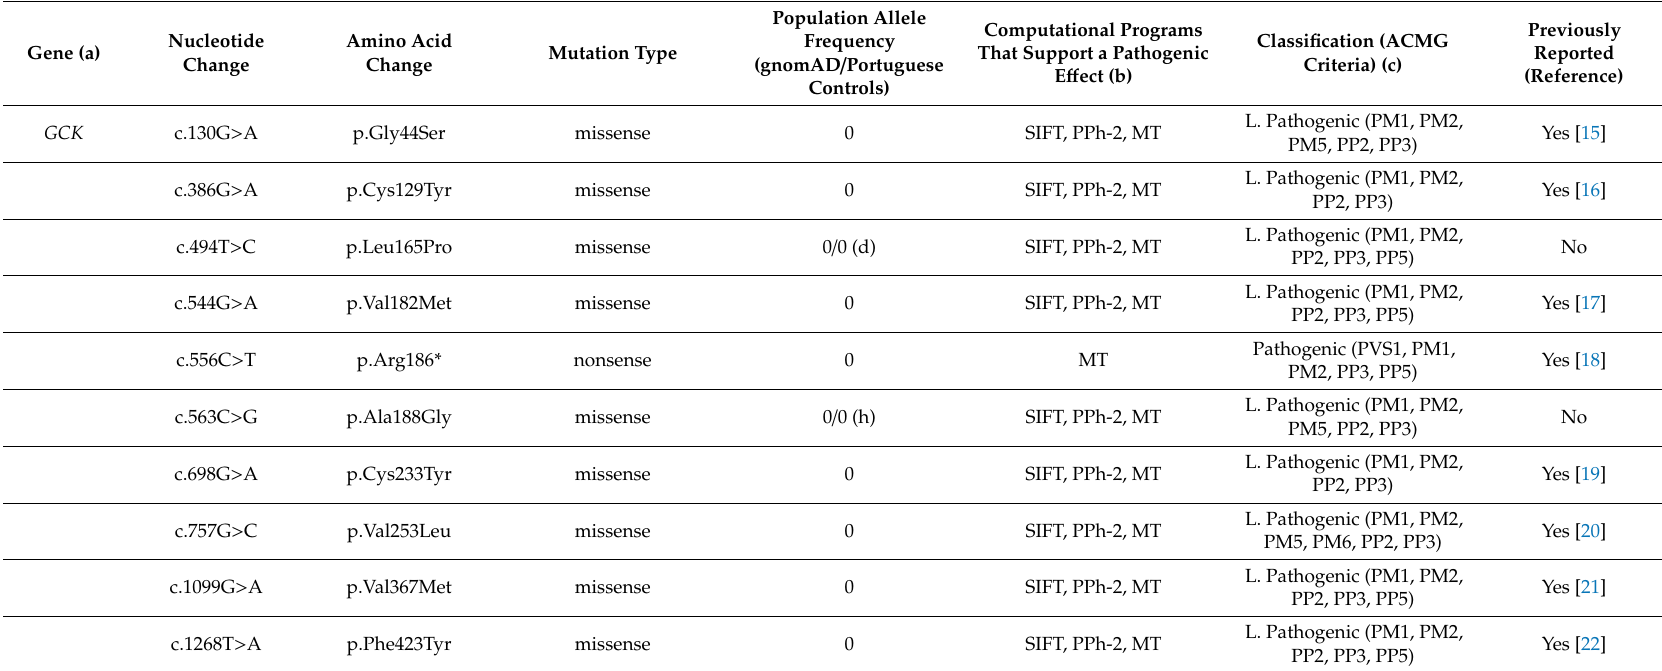
Table 1. Rare sequence variants identified in MODY